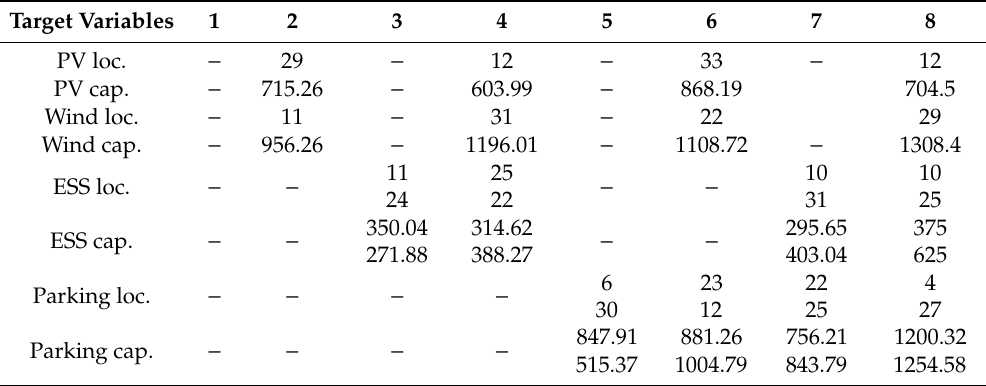
Figure 6. Network 24-hours electrical demand profile (scenario 1). Table 7. Obtained values for target variables through optimization Table 6. Description of the conducted scenarios.